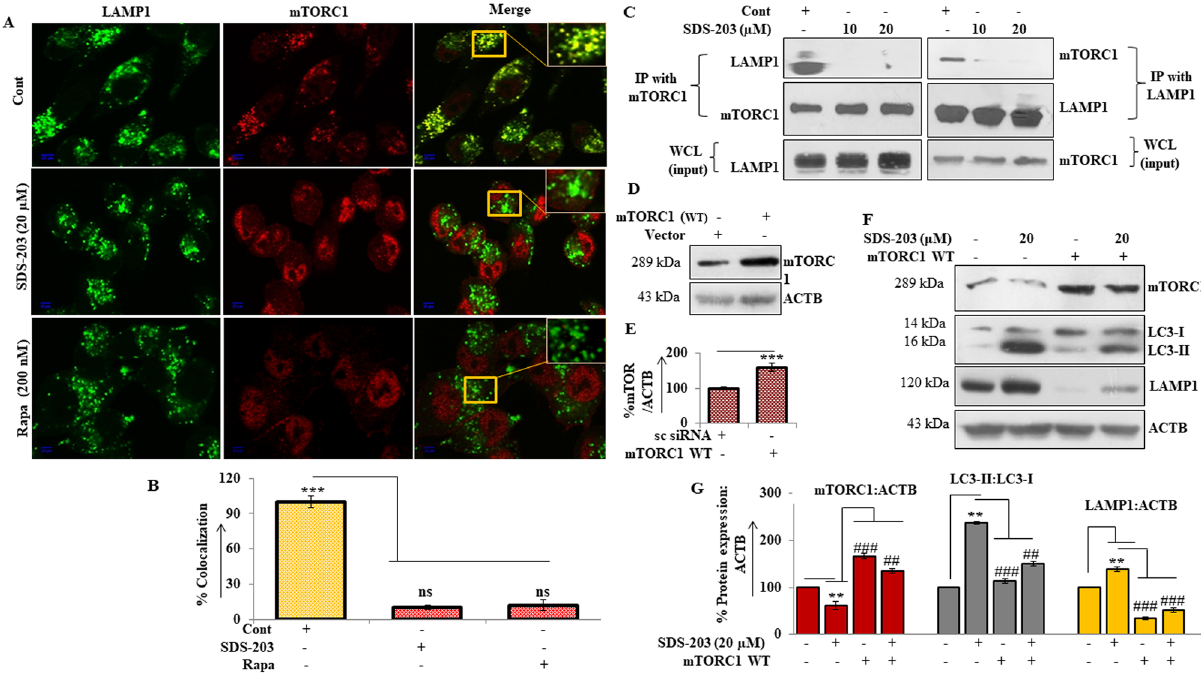
Figure 6. SDS-203 participates in lysosomes and autophagosome fusion inhibitor. ( A ) MIA PaCa-2 cells treated with SDS-203 prior to fluorescent antibody labeling against endogenous LAMP1 (green) and mTORC1 (red) colocalization (yellow). ( B ) Shows treatment colocalization correlation compared to control. ( C ) Pancreatic cancer cells were treated with SDS-203 (0, 10, 20 µM) and taken for mTORC1 and LAMP1 interaction investigation by immunoprecipitation ( ip immune precipitation, WCL whole cell lysate). ( D , E ) Represents the expression of mTORC1 in vector or WT mTORC1 plasmid transfected cells and its quantification respectively. ( F ) SDS-203 treated to mTORC1 overexpressed MIA PaCa-2 cells and expression of LC3-II and LAMP1 were detected. ( G ) Densitometry of blots. Each experiment was repeated thrice, ip experimentation was done twice, and the present data represent the mean of three individual experiments, taken as ± SEM, where **or## p < 0.01 and ***or### p < 0.001 vs.